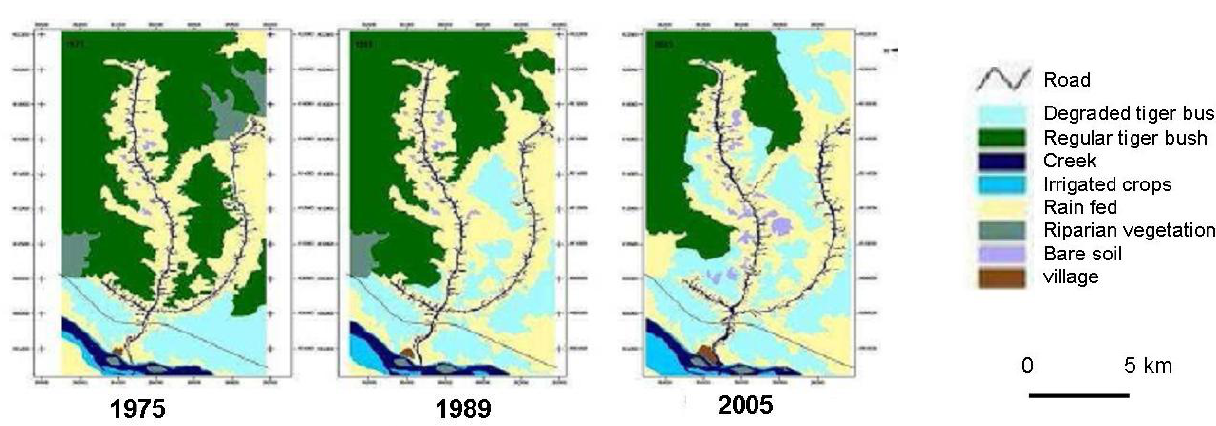
Figure 4. Boubon basin (20 km NW of Niamey): an endorheic basin became an exorheic one, probably due to the strong spatial extension of degraded vegetation and soils.